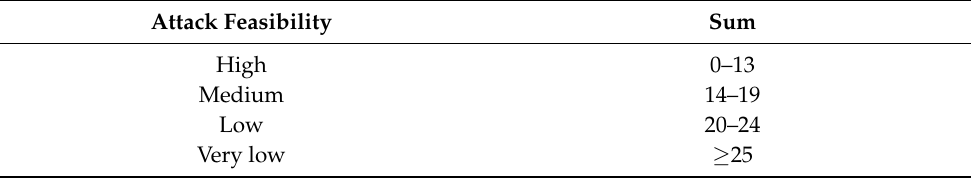
Table 4. AAFL rating criteria.